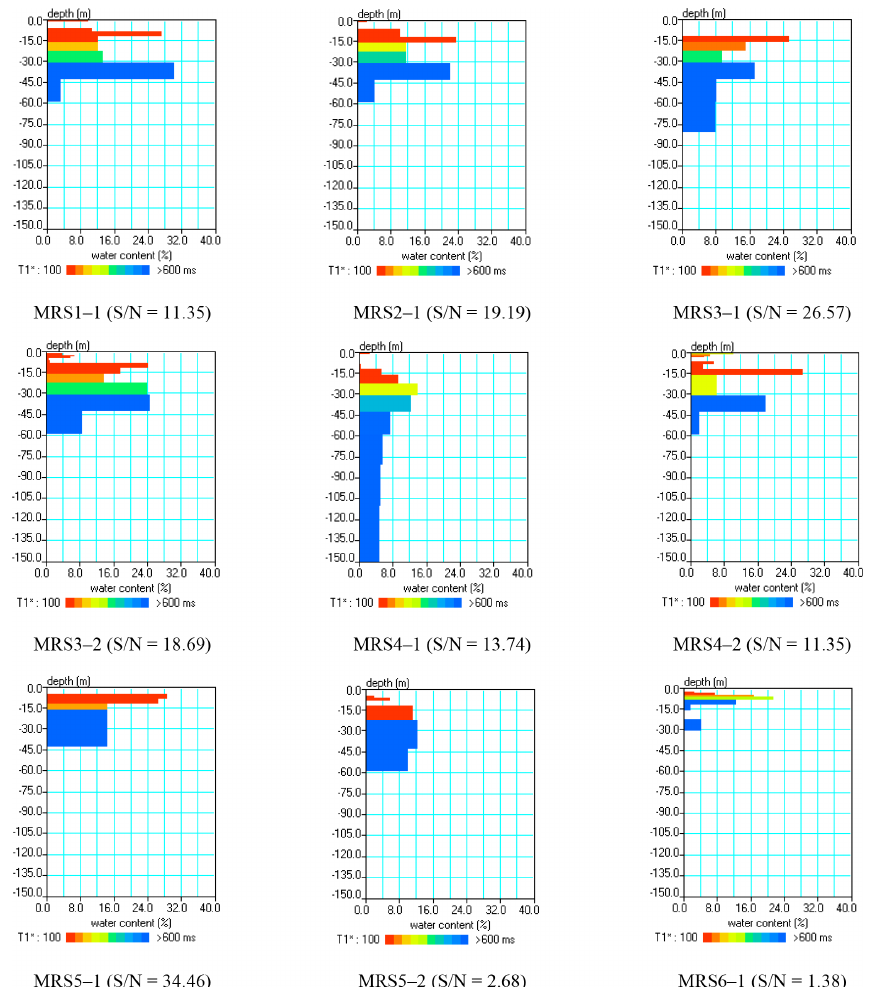
Earth Syst. Sci. Data, 13, 4727–4757,